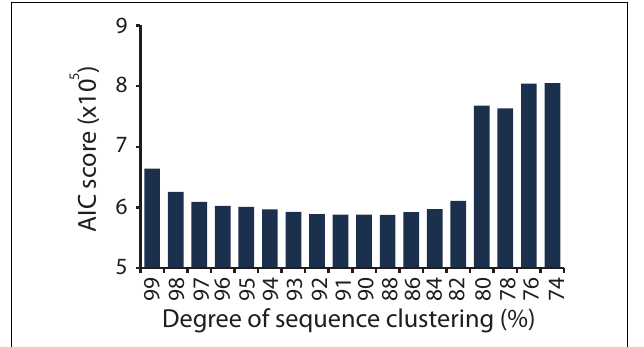
FIGURE 2 | AIC scores calculated from the bipartite network of sequences and plots, for sequences clustered at a range of similarities, from 74 to 99%.